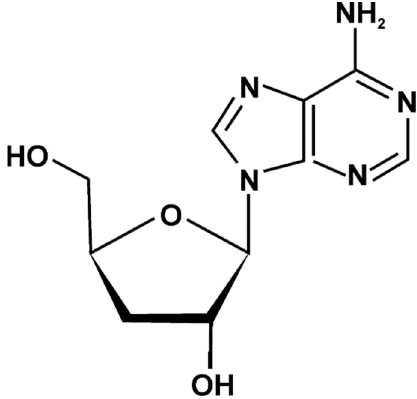
Figure 1. Chemical structure of cordycepin.